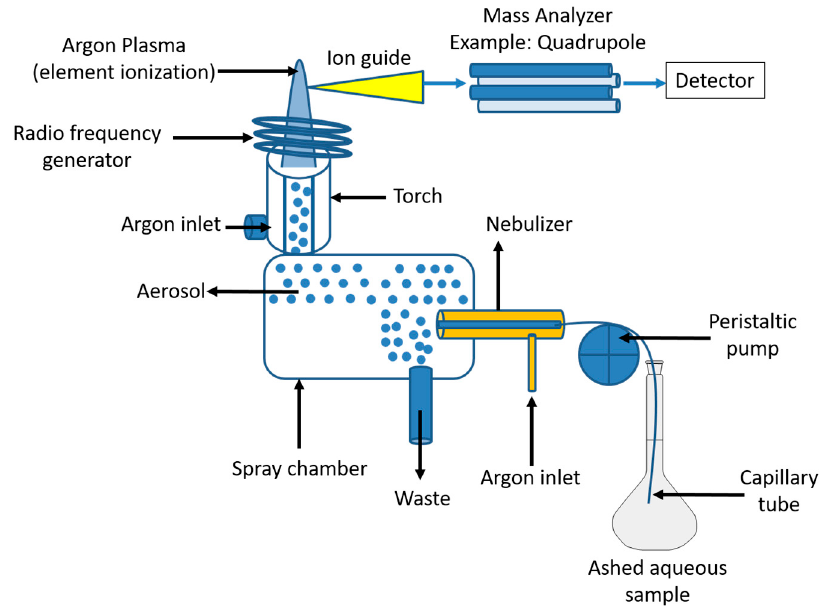
Figure 5. Inductively coupled plasma mass spectrometry (ICP-MS) principle.